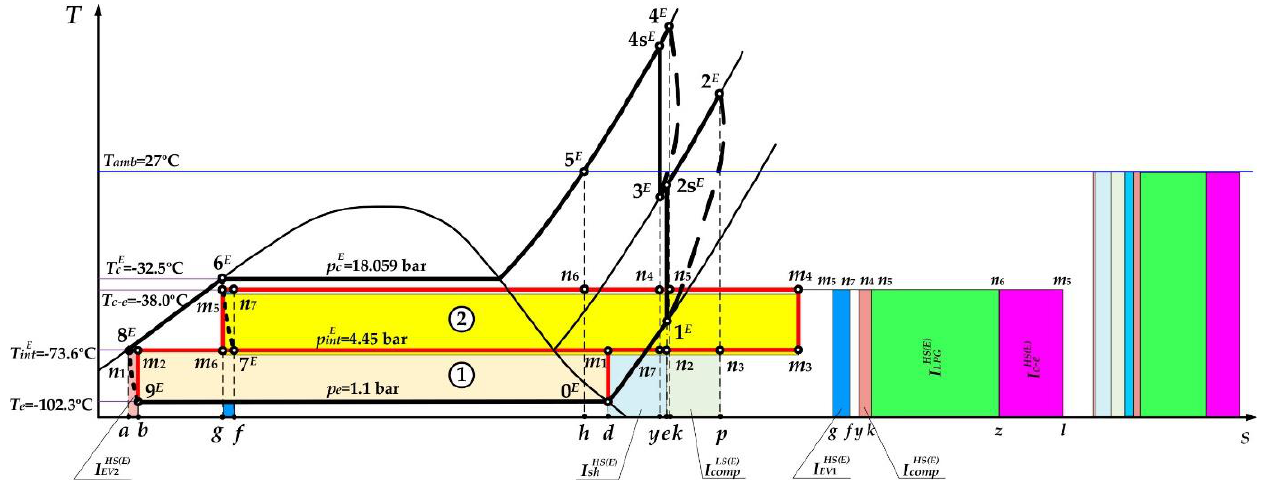
Figure 7. Determination of irreversibilities in the bottoming stage of the cascade ethylene reliquefaction system.